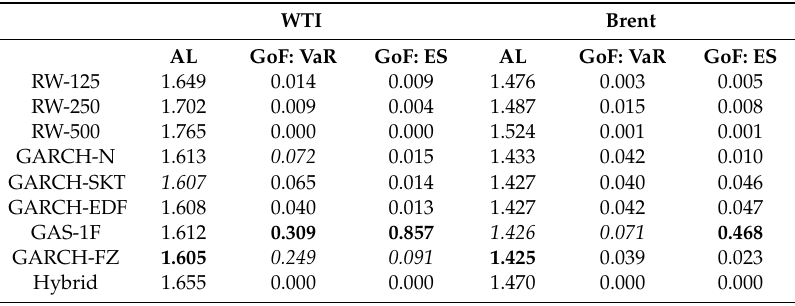
Table 4. The out-of-sample average losses and goodness-of-fit tests ( α = 0.05).